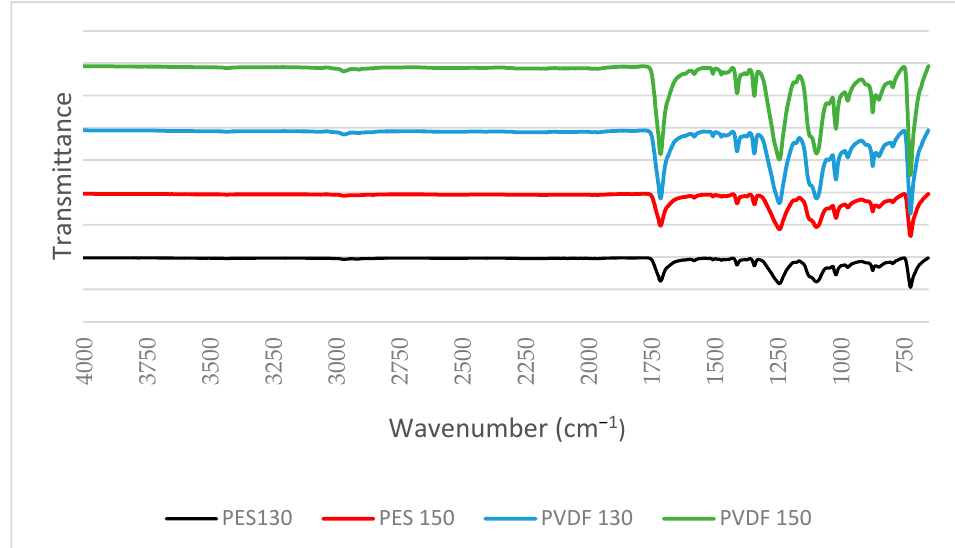
Figure 5. FTIR spectra of PES and PVDF membranes.